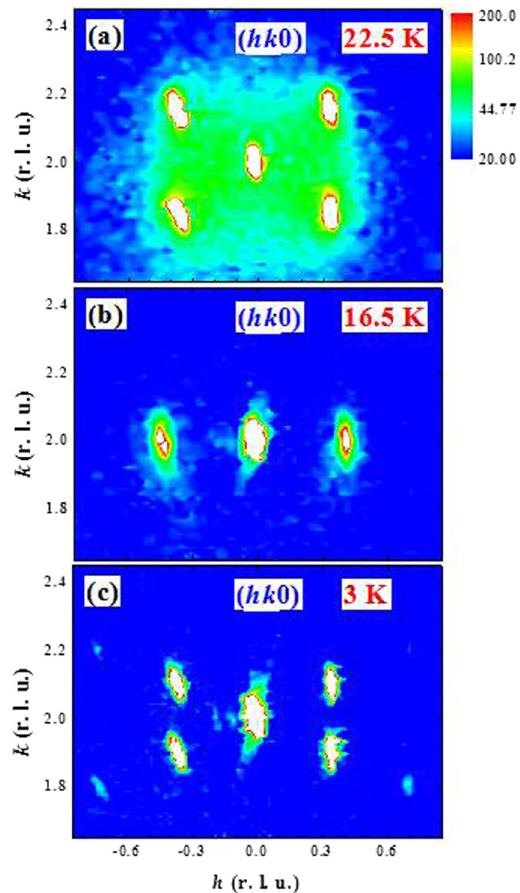
Figure 9. Neutron-diffraction intensity maps in the ( hk0 ) scattering plane near the (020) Bragg position observed at ( a ) 22.5 K, ( b ) 16.5 K and ( c ) 3 K. Four satellite magnetic reflections appear at 22.5 K, but the incommensurability along the h direction vanishes at 16.5 K, demonstrating the occurrence of a magnetic phase transition. The incommensurability along the k direction is re-established below T M4 , demonstrating the occurrence of another magnetic phase transition. Second-order peaks are also observed in the ground